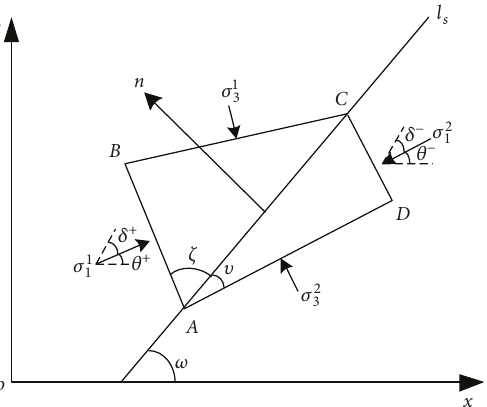
Figure 6: Stress elements on both sides of stress discontinuity